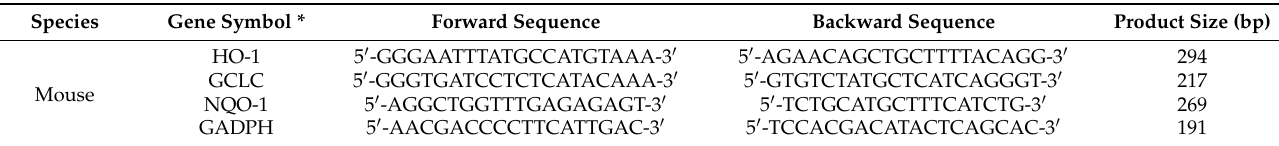
Table 1. Oligonucleotide sequences used in the present